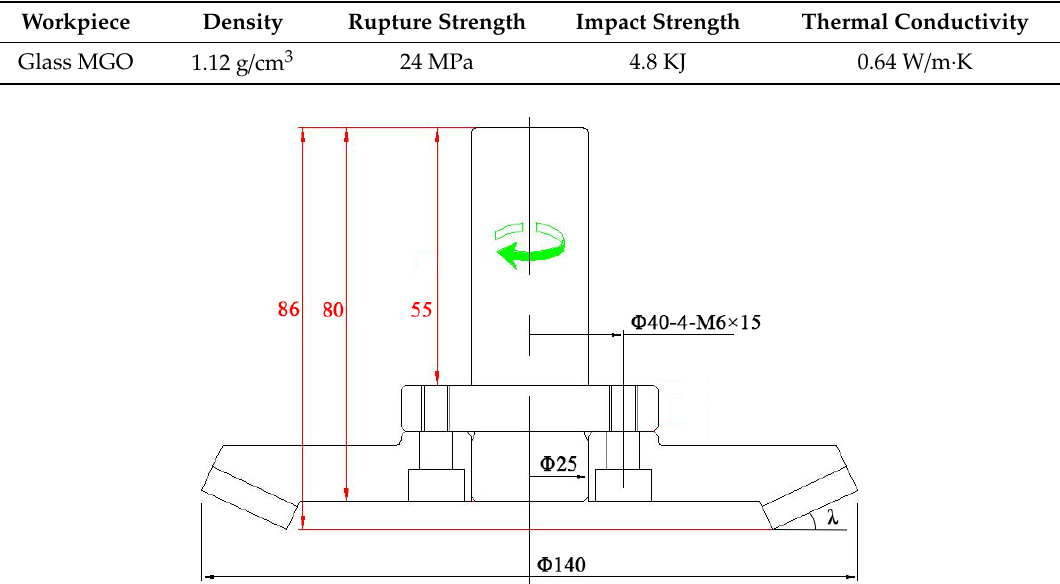
Table 1. Material properties of glass magnesium (MGO) board.